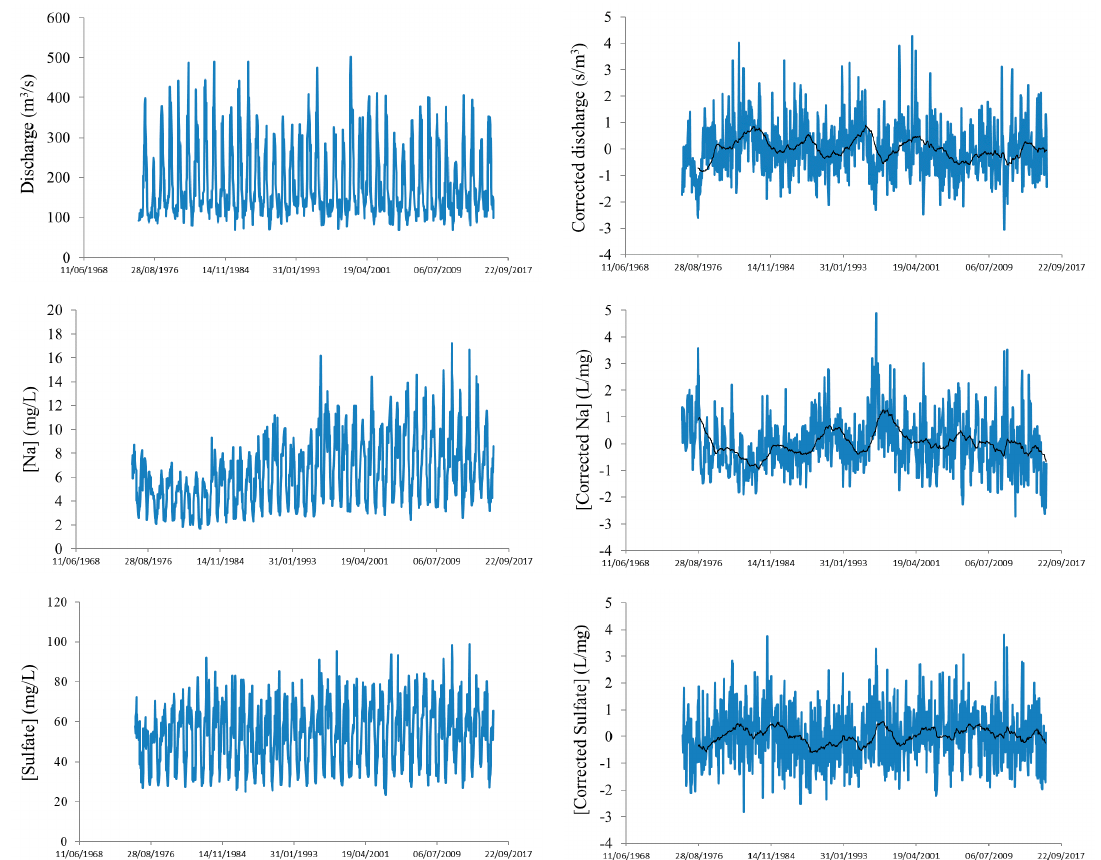
Figure 1. Original and corrected time series for discharge, sodium, and sulfate. Black lines in the corrected time series plots are moving averages (with a period of 48 two-weeks).